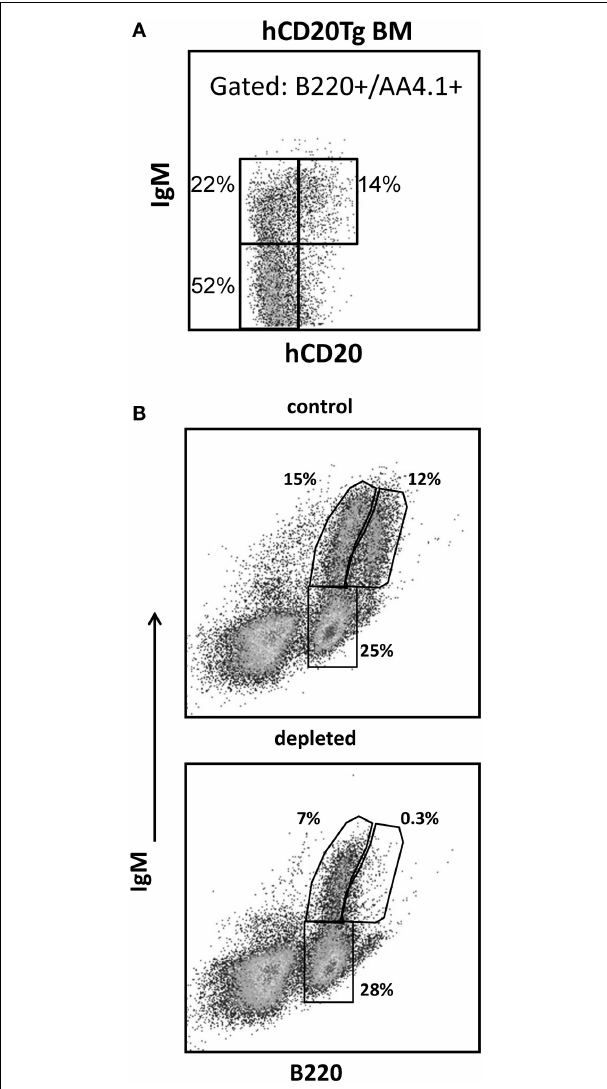
FIGURE 2 | Selective depletion of BM B cell subsets in an hCD20Tg mouse . (A) BM cells from hCD20Tg mouse were stained for B220, IgM, AA4.1, and hCD20. For analysis, viable lymphocyte were defined by forward and side light scatter, and gates were set to analyze B220 + /AA4.1 + early developing B cells (pro-/pre-B and immature B cells) and to exclude circulated B220 + /AA4.1 (cid:0) and non-B lineage cells. Gated cells were analyzed for expression of IgM and hCD20. (B) hCD20Tg mice were injected with anti-hCD20 antibodies. Three days after injection, BM cells were stained for B220 and IgM and analyzed for the following B cell subsets: pre-/pro- (B220 + /IgM (cid:0) ), immature (B220 + /IgM + ), and circulated mature (B220hi/IgM + ) B cells, relative to control hCD20Tg mice that were not treated. The results shown are representative of three to four mice in each